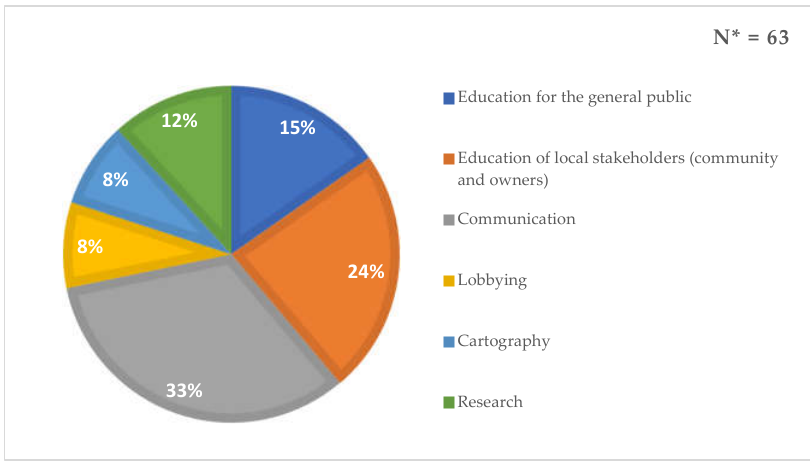
Figure 2. Mediation strategies used by stakeholders [5]. N*: total number of responses.